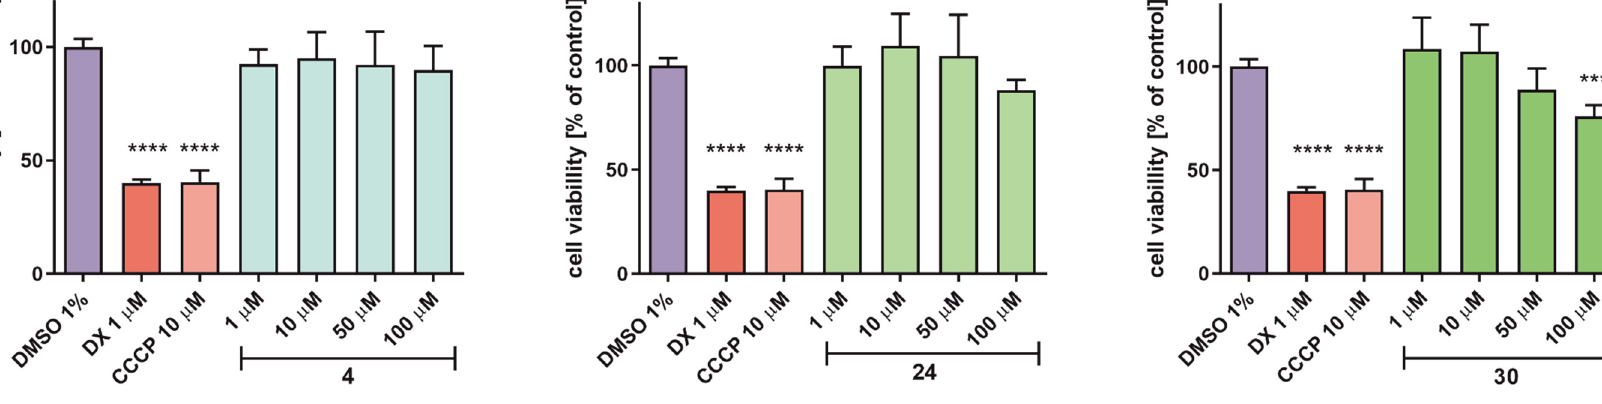
Figure 8. The effect of 4 , 24 , 30 , and cytostatic drug doxorubicin (DX) and the mitochondrial toxin carbonyl cyanide 3-chlorophenyl-hydrazone (CCCP) on hepatoma HepG2 cell lines viability after 72 h of incubation at 37 °C, 5% CO 2 . The statistical significance (GraphPad Prism 8.0.1) was evaluated by a one-way ANOVA, followed by Bonferroni’s comparison test (*** p < 0.001, **** p < 0.0001) compared with negative control dimethyl sulfoxide (DMSO) 1% in growth medium).